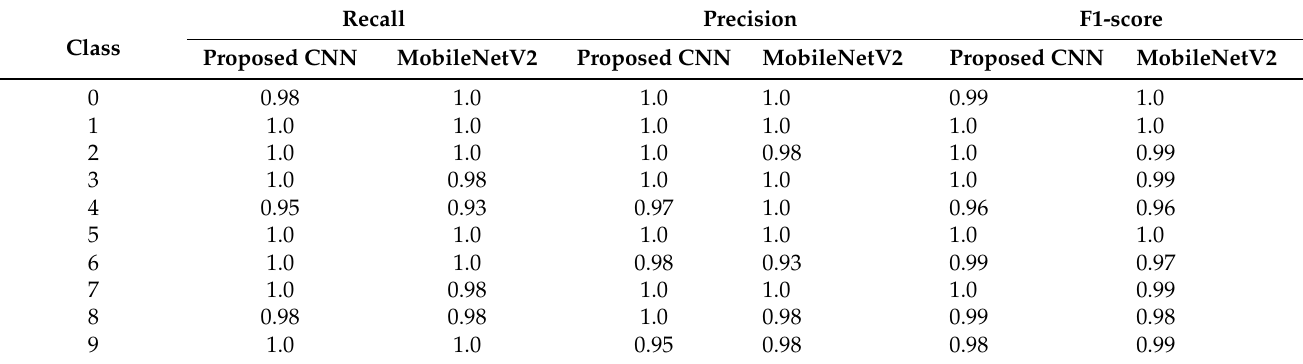
Table 8. Recall, Precision and F1-score evaluation metric values for both the proposed model and MobileNetV2